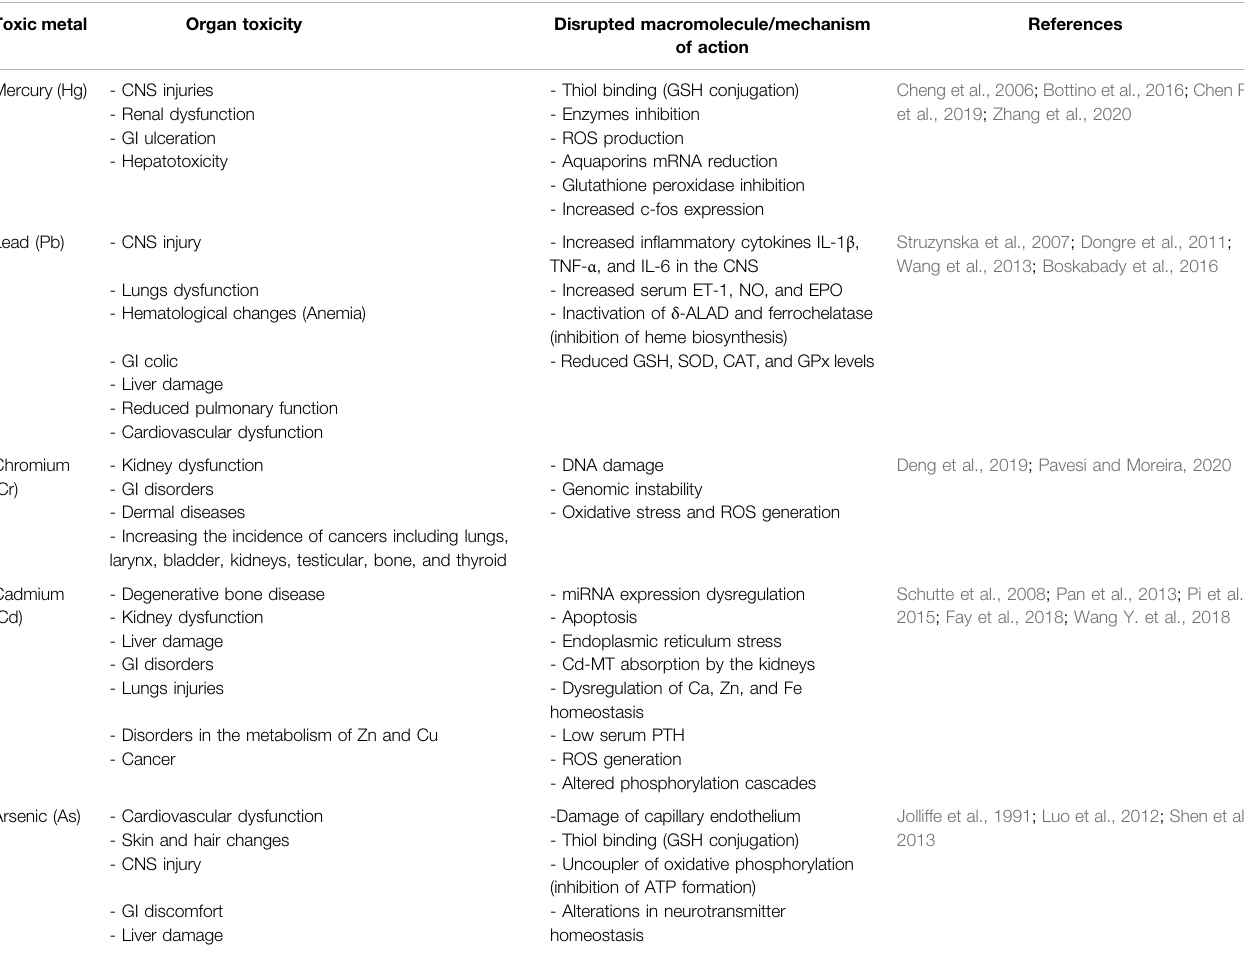
TABLE 1 | Toxic mechanisms of Hg, Pb, Cr, Cd, and